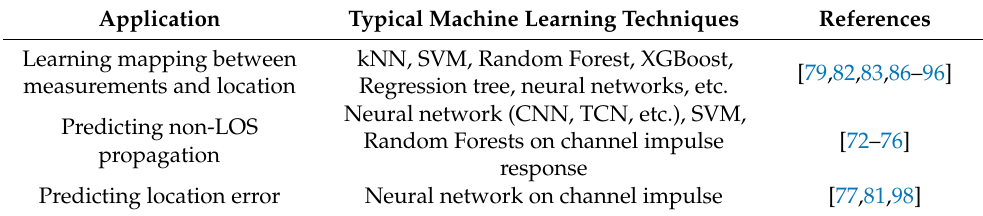
Table 2. Summary of applications of machine learning techniques in IIoT asset